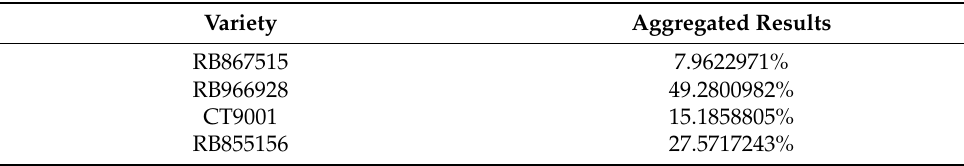
Table 6. Aggregated results for both decision-makers 1 and